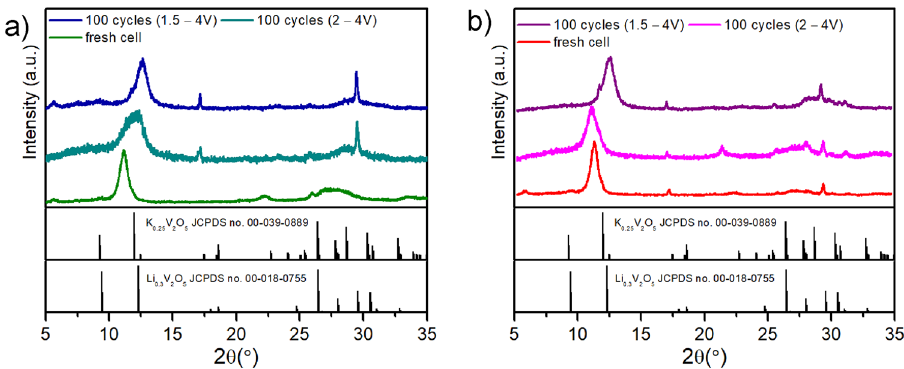
Figure 5. Ex-situ XRD pattern of the ( a ) KVO-20 and ( b ) KVO-40 electrode at the pristine state and a fully discharged state electrode after 100 charges/discharge test at j = 1 Ag −1 in two potential ranges.